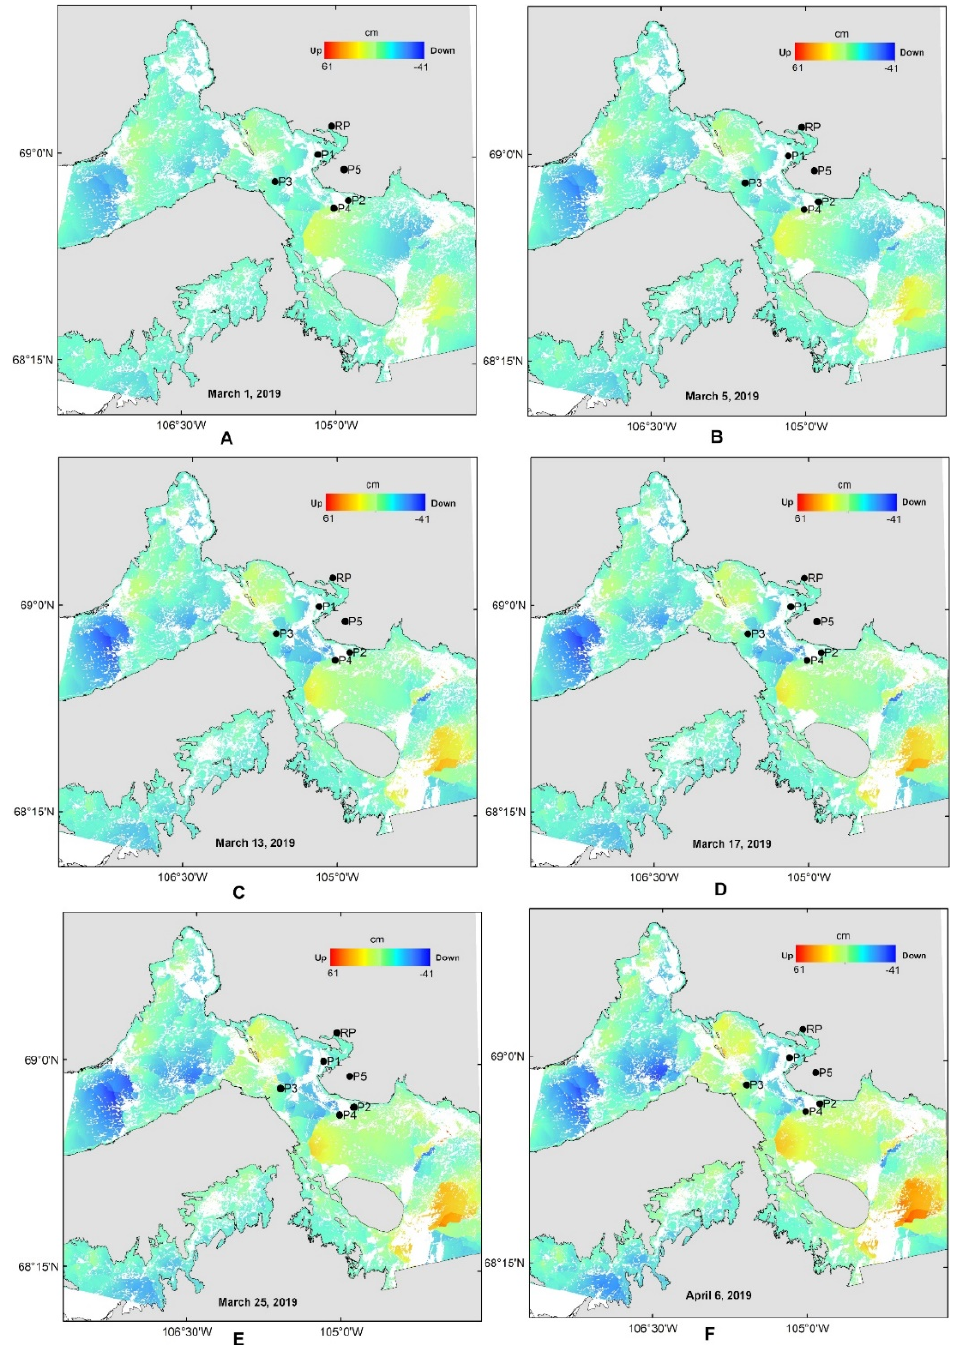
Figure 11. ( A – F ) Vertical deformation from Sentinel-1A and B modes (+ for upward movement, − for the downward movement). The grey and white color represent land and no measurements, re- spectively.